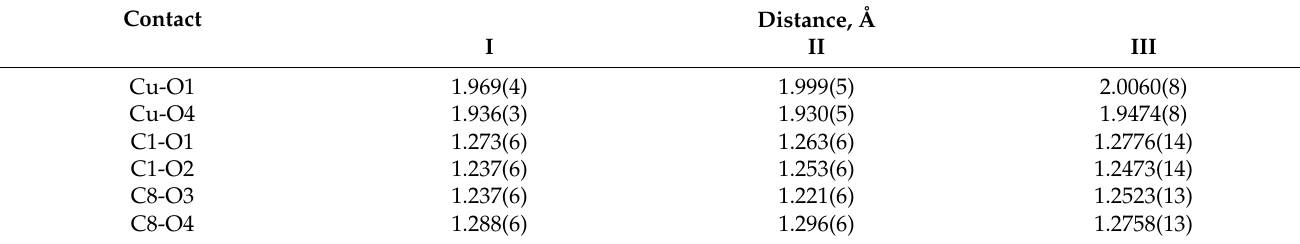
Table 2. Comparison of selected bonds distances in compounds I – III .